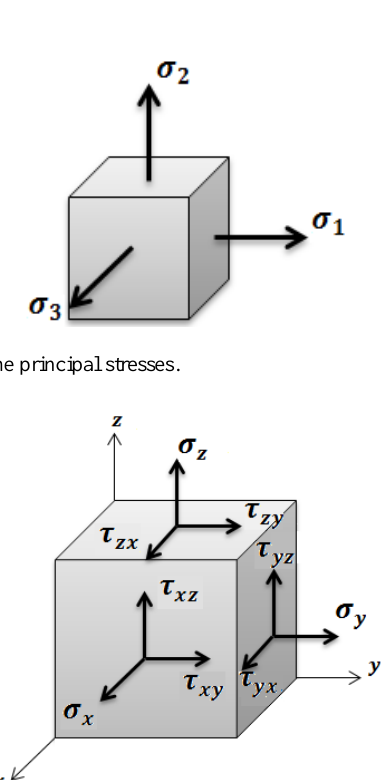
Figure 6. Convergence analysis.